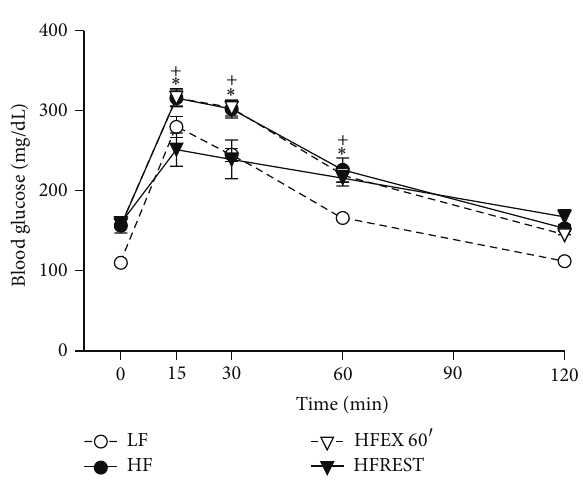
Figure 4: Glucose tolerance test in mouse subjected to control diet (LF), high-fat diet (HF), high-fat diet with exercise 60 󸀠 (HFEX 60 󸀠 ), and high-fat diet with 30% food restriction (HFREST). The glucose levels of LF were different from the other groups at time 0, 30, and 60 minutes ( 𝑃 < .05 ). Mean ± SEM, 𝑛 = 5 mice per group ( + 𝑃 < 0.05 , HFEX 60 󸀠 versus HFREST; ∗ 𝑃 < 0.05 , HF versus